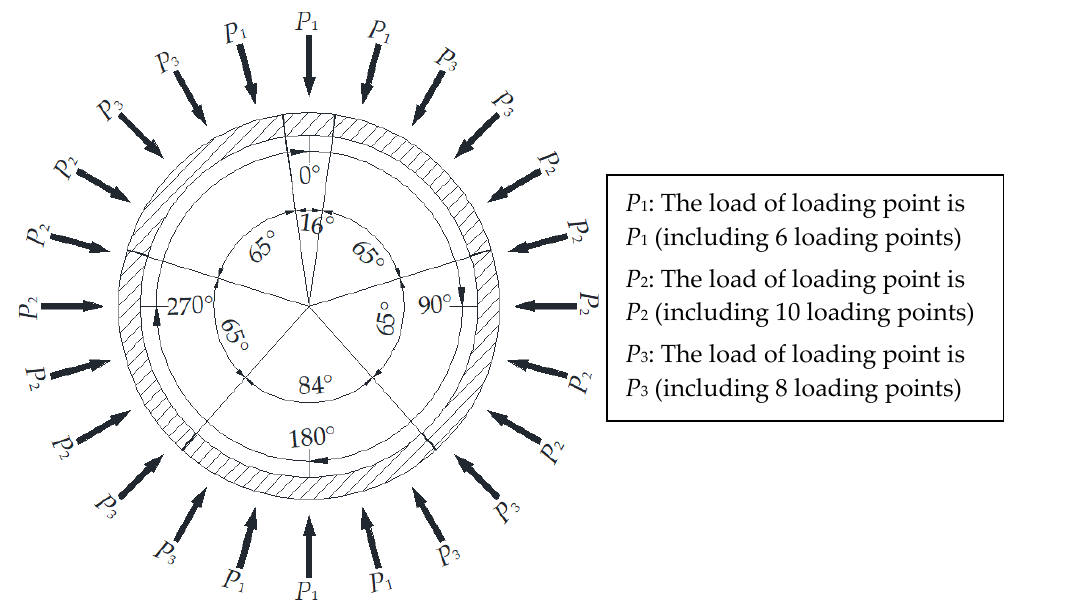
Figure 2. Force distribution and segment ring division. Table 1. Deformations measured in the full-scale test.